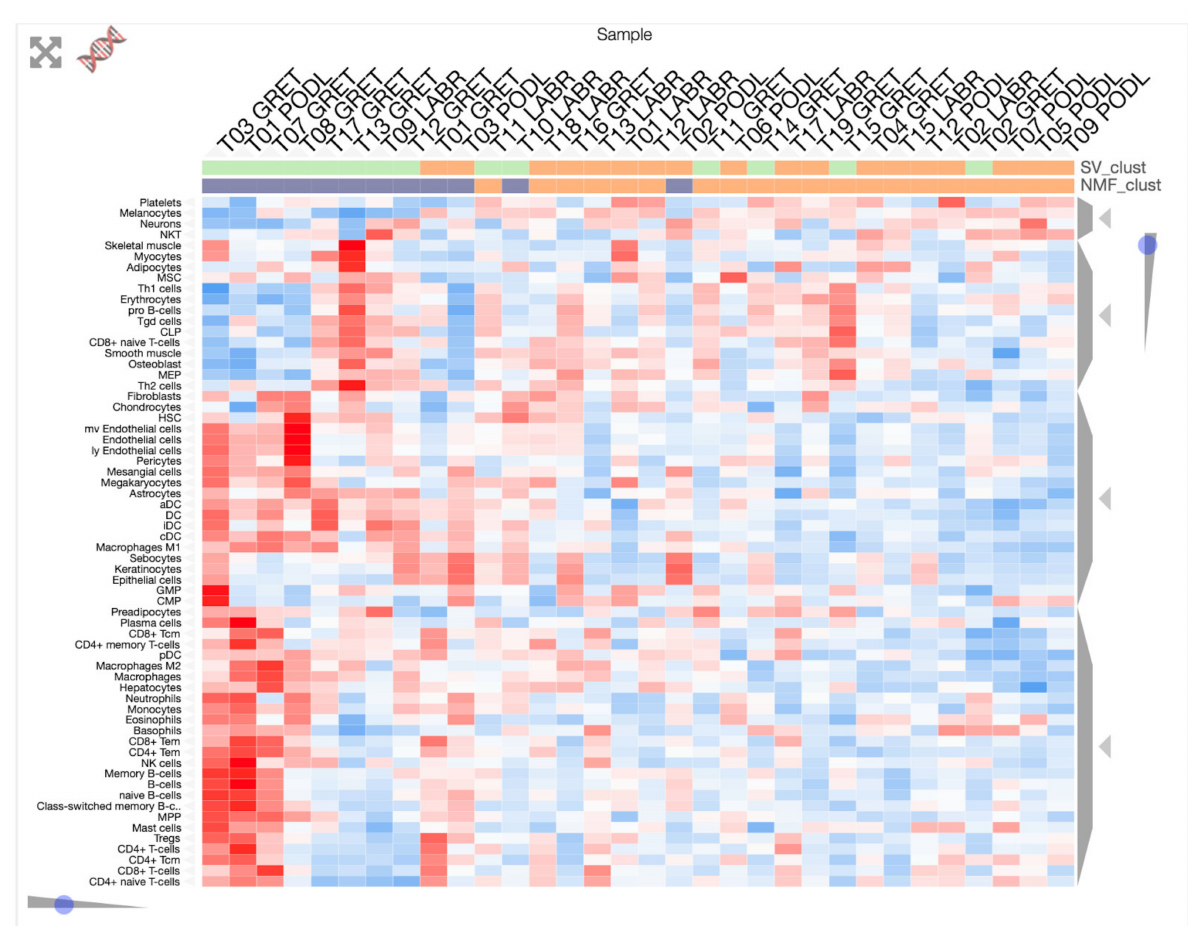
Figure A9. Cell types enrichment analysis in MM. Cell type enrichment analysis were performed with xCell program [83] with 64 immune and stroma cell types and MM are then clustered using clustergrammer [100]. Enrichment for immune cells such as dendritic cells, macrophages M1 and lymphocytes T is observed in the group 1 with low SV content (SV_clust = clustering of MM samples based on SV content with group1 in light green and group2 in orange, NMF_clust = clustering of MM samples based on NMF with RNASeq data with group1 in purple and group2 in